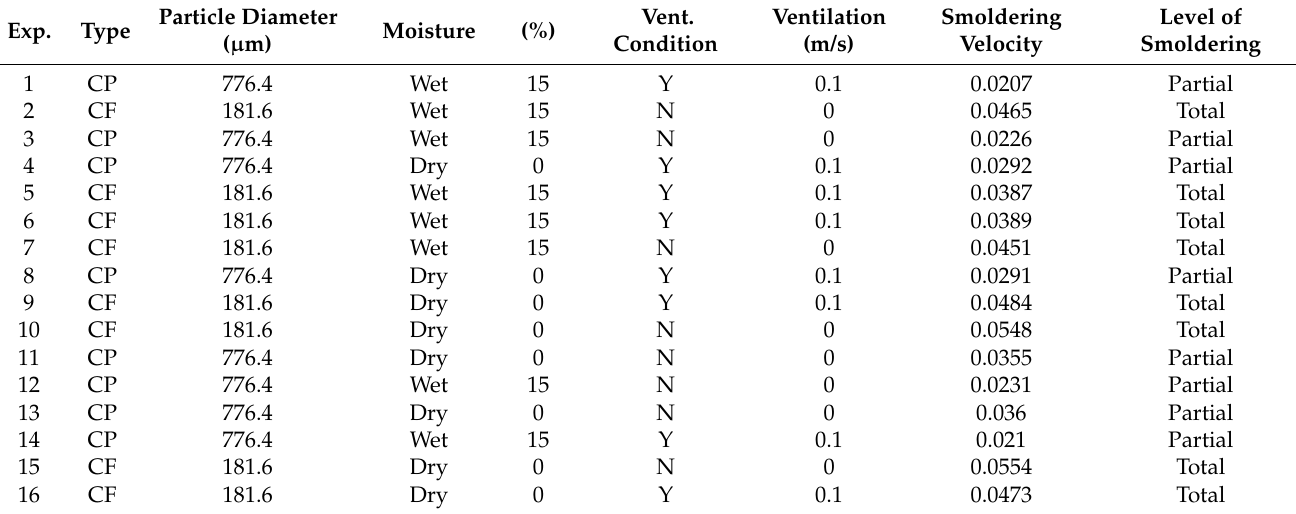
Table 3. Experiment